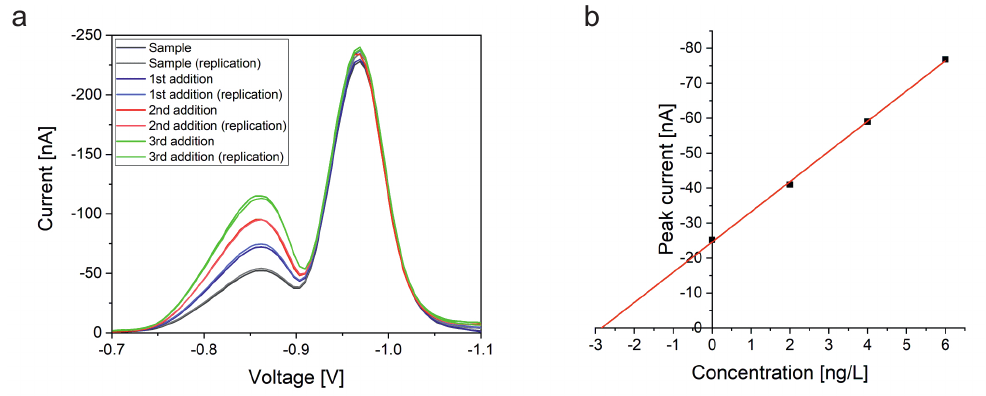
Figure 9. ( a ) Recorded voltammograms of fuel cell product water collected during the dynamic load cycle and the corresponding results of the standard addition calibration as measured by HMDE.